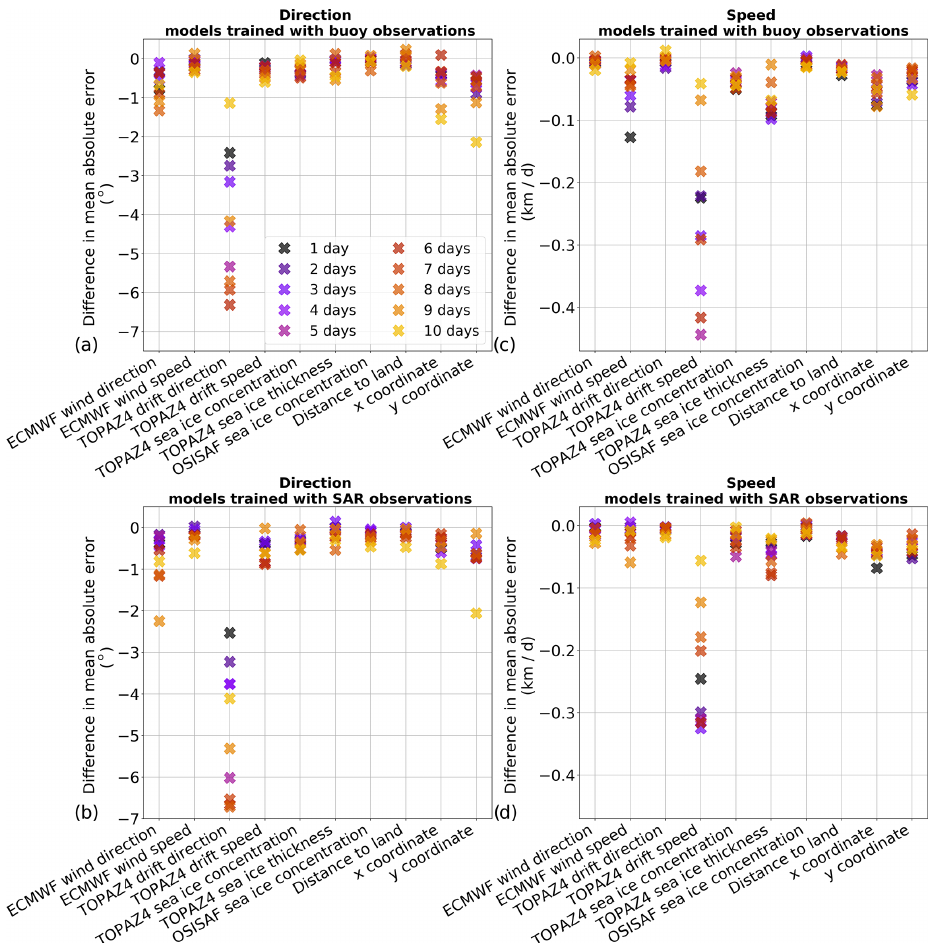
Figure 9. Differences in mean absolute error when one of the predictor variables is not used in the random forest models for the direction (a, b) and speed (c, d) of sea ice drift. The results are shown for the models trained with buoy observations (a, c) and for the models trained with SAR observations (b, d) . The lead times are indicated in the legend of (a) . The differences represent the subtraction between the performances of the models using all the predictor variables and the models in which one predictor variable was not used. Therefore a negative value means that adding the variable in the algorithm improves the